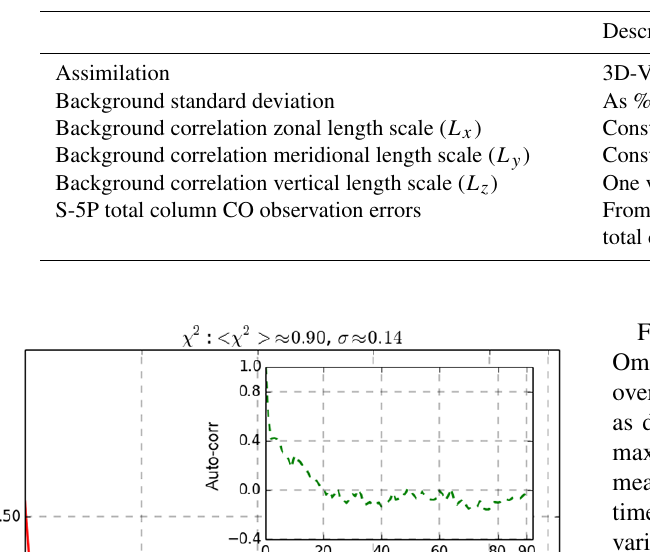
Table 2. Description of the configuration used in the assimilation system.